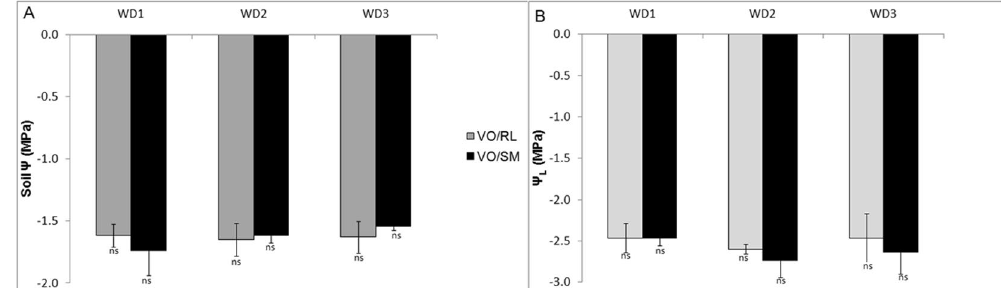
Figure 1. ( A ) Soil matrix potential (soil Ψ ; MPa). ( B ) Leaf water potential before sunrise ( Ψ L ; MPa) under severe water deficit conditions for the different plant groups exposed to recurrent water deficit (WD1, WD2 and WD3), Valencia Orange/Rangpur lime (VO/RL-gray bar) and Valencia Orange/Sunki Maravilha (VO/SM-black bar) with Ψ ≥ 2,0 MPa. NS indicates no significance (P ≤